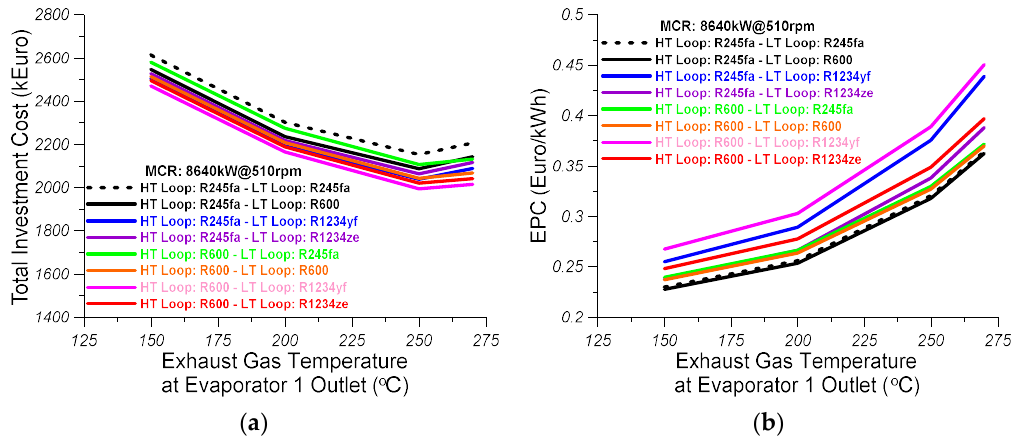
Figure 18. (a) Effect of the exhaust gas temperature after the evaporator 1 of the HT loop on the total investment cost of the regenerative dual-loop ORC; (b) Effect of the exhaust gas temperature after the evaporator 1 of the HT loop on the electricity production cost (EPC) of the regenerative dual-loop ORC. Results are given for all the pairs of organic mediums that are examined in the present study.